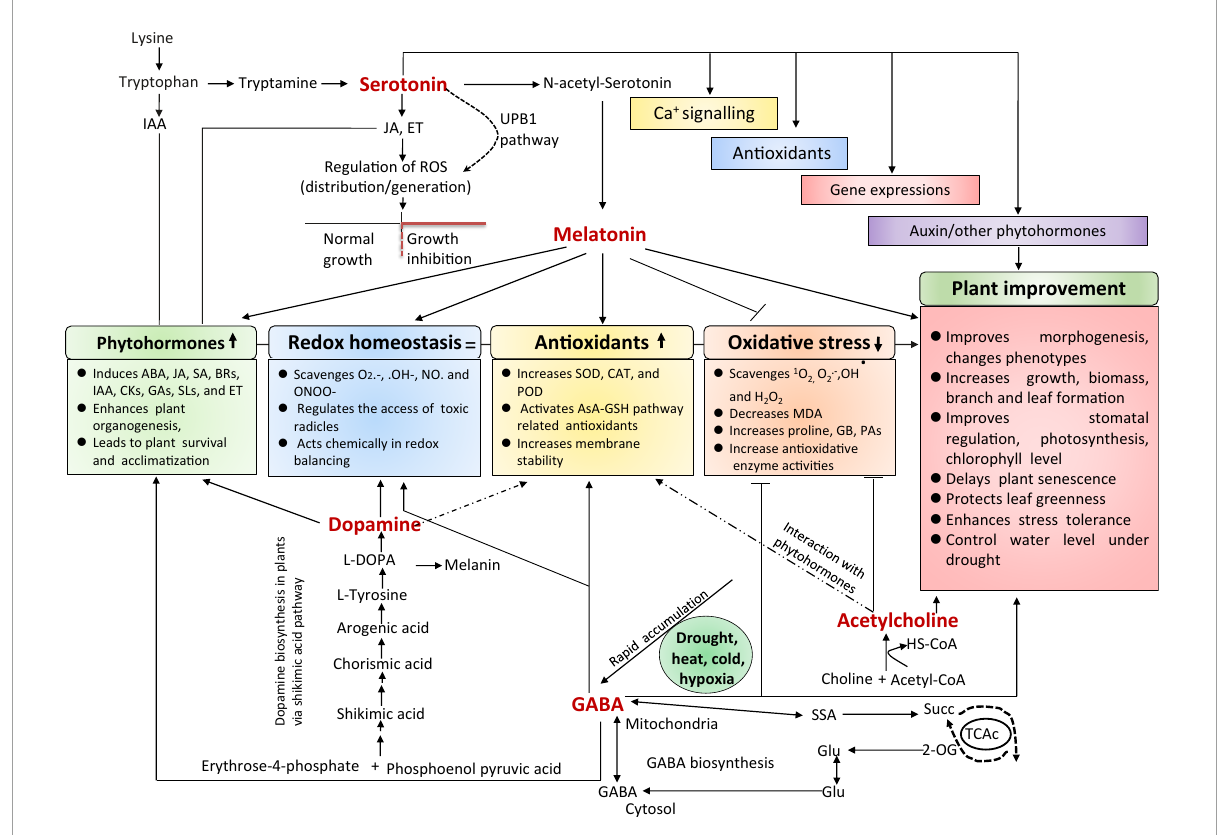
FIGURE6 Possible mechanisms for the interaction of neurotransmitters and phytohormones and their roles in several physiological processes. Phytohormones and NTs coordinate as growth regulators, antioxidant activators, redox state managers, and oxidative stress reducers, improving plant growth and enhancing multiple stress tolerances. The illustration presents a series of physiological and biochemical mechanisms linked to the interaction of five NTs with different plant growth regulators. The solid and dashed lines indicate strong and weak interaction, respectively. Lines with bars show the inhibition of a physiological process by NTs. During this process, GABA accumulates rapidly in response to several abiotic stresses. GABA, γ -aminobutyric acid; ABA, abscisic acid; GAs, gibberellic acids; IAA, indole-3-acetic acid; SA, salicylic acid; BRs, brassinosteroids; JS, jasmonic acid; CKs, cytokines; GAs, gibberellic acids; SLs, strigolactones; ET, ethylene; SOD, superoxide dismutase, CAT, catalase; POD, peroxidase; AsA-GSH, ascorbate-glutathione; H 2 O 2 , hydrogen peroxide; 1 O 2 , singlet oxygen; O •− 2 , superoxide; OH, hydroxyl radical; MDA, malondialdehyde; GB, glycine betaine; Pas, polyamines; UPB1; UPBEAT1 transcription factor; Glu, glutamate; 2-OG, 2-oxoglutarate; TCAs, tricarboxylic acid cycle; SSA, succinic semialdehyde; Succ,